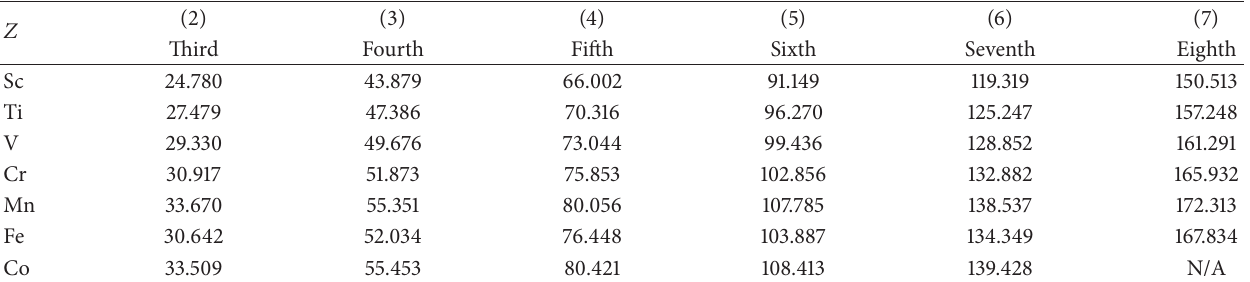
Table 7: Ionization energies (eV) of isoelectronic series using (20) and constants/coefficients in Table 2 ∗ .